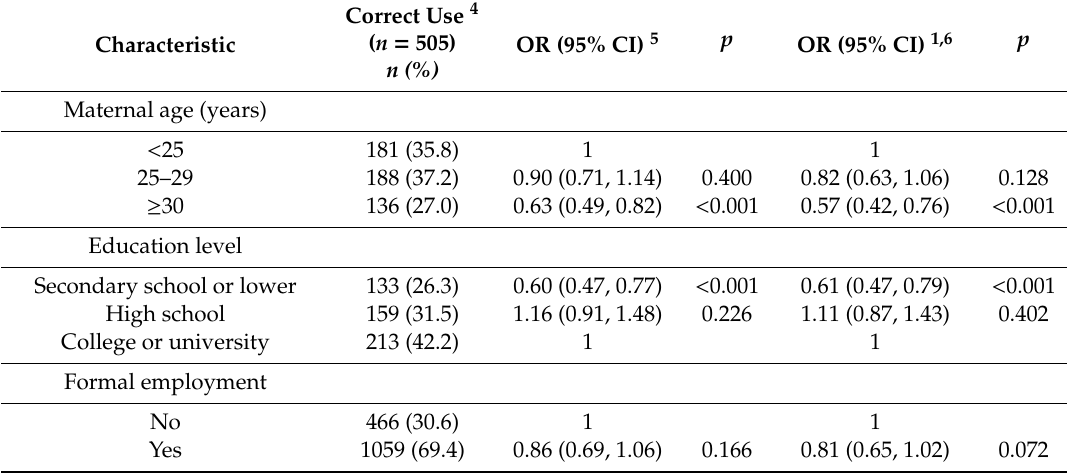
Table 2. Maternal characteristics associated with the correct use of supplements containing folic acid alone during the periconceptional period in Vietnam, 2015–2016 ( n =